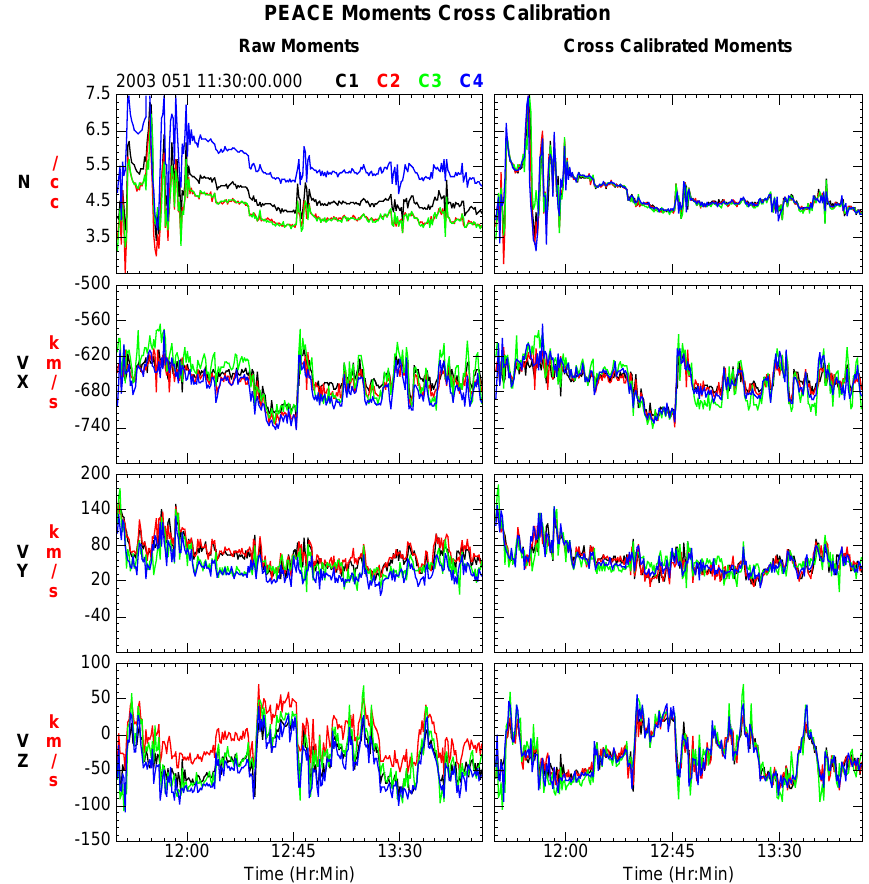
Fig. 2. Cross calibration of PEACE moments across the